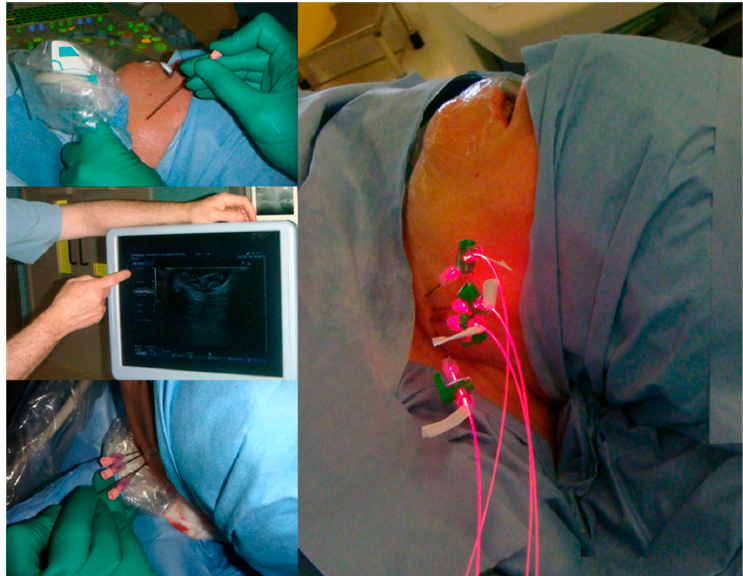
Figure 12. Images of US-guided mapping of needle insertion location in order to avoid the carotid artery. Fibres are introduced through the needles into the tumour bulk, and illumination can be seen. Reprinted with permission from ref. [80]. Copyright 2009 Lasers Surg. Med.